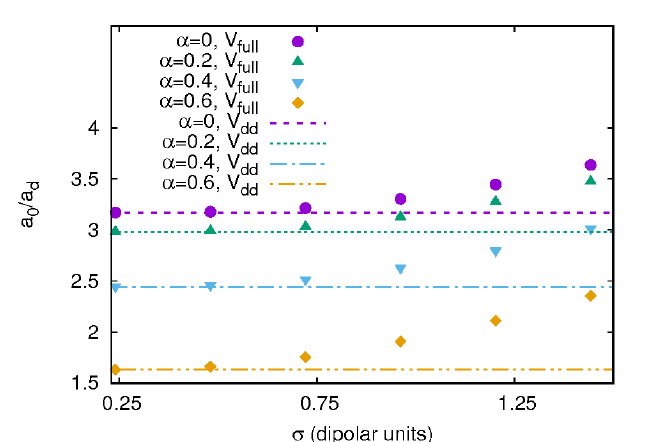
Figure 7: Scattering length of the compound system described by the Hamiltonian in Eq. (14) corresponding to a dipolar system with an additional Van der Waals tail, as a function of σ and for different polarization angles. Here, σ is given in dipolar units, with the characteristic length and energy scales given by l = a